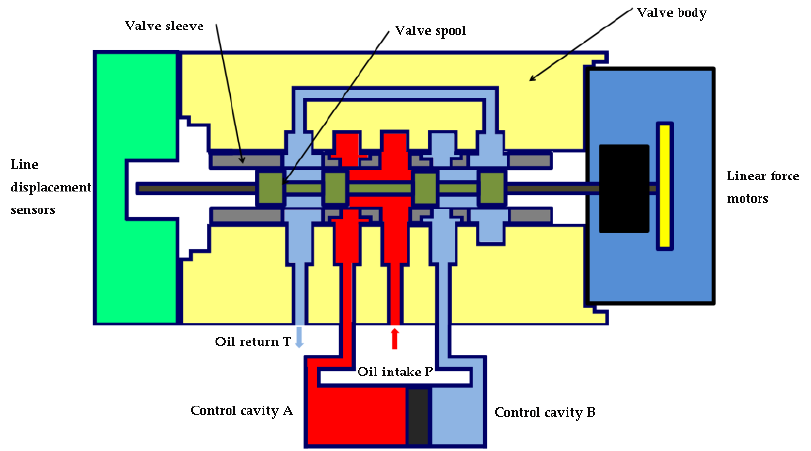
Figure 3. Spool moves to the left; left inlet port opens.